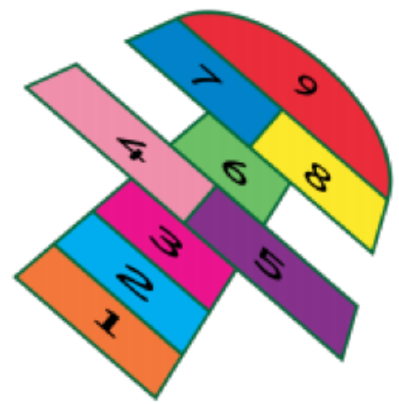
Figure 4. Interface of the game “Hopscotch”.